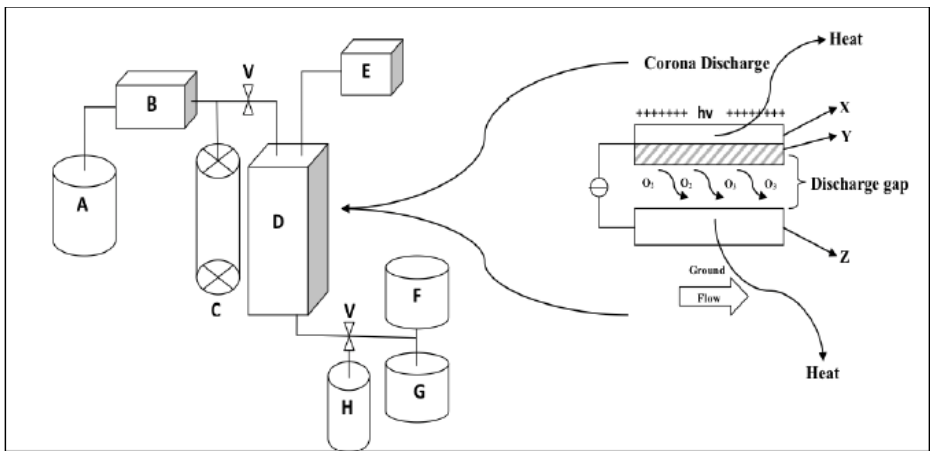
Figure 6. Schematic diagram for set-up of ozone generator highlighting corona discharge instrument: Key: A = Oxygen cylinder; B = Flow rate controller; C = Bubble type flow meter; D = Ozone generator; E = Transformer; F and G = Excess ozone traps (4% KI); H = Rotating vessel (90 rpm); V = Valve; X = High tension electrode (Source: Okpala, [103]; Permission to use not required).